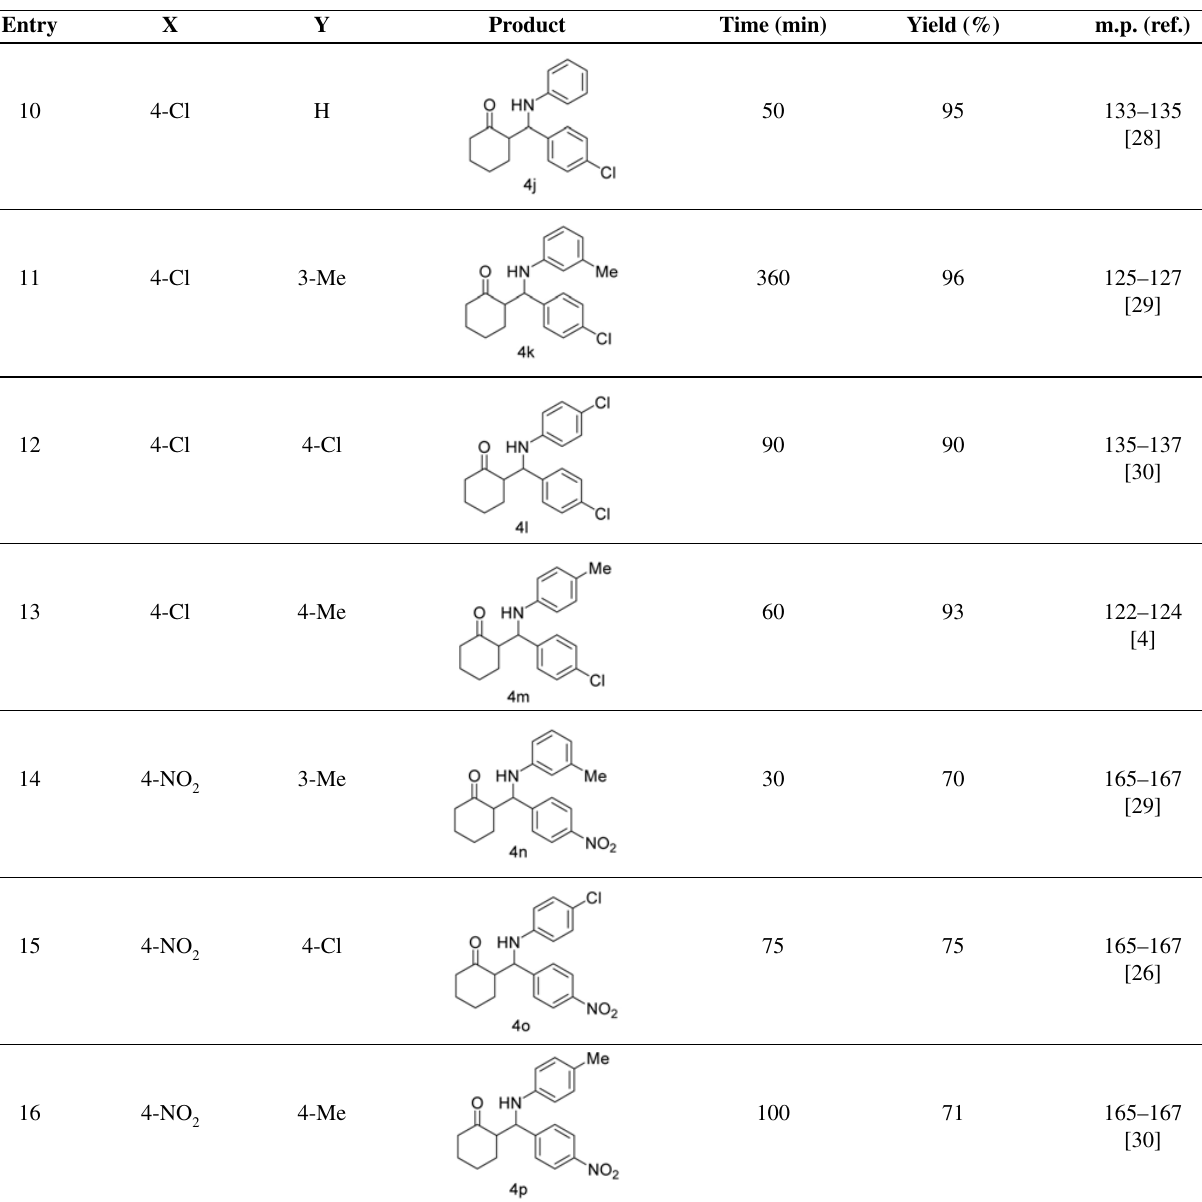
(Table 2, 4d ): Yield: 94%, White solid; syn / anti : 0/100,